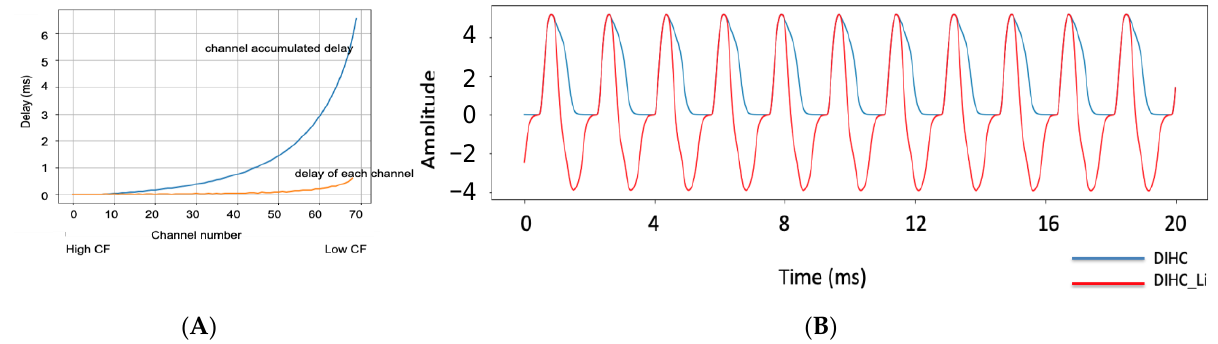
Figure 4. ( A ) Delay of CAR-FAC channels against centre frequency (CF) to a speech and delay of each CAR-FAC channel; ( B ) The CAR-FAC IHC (blue) and the lateral inhibition (red) response to a 500 Hz sine wave on its CF channel (CF corresponds to 500 Hz).